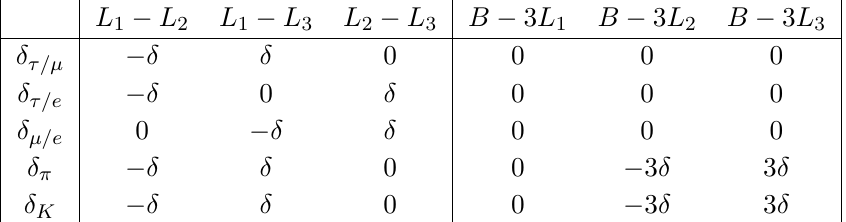
Table 2 . Expressions for (cid:14)